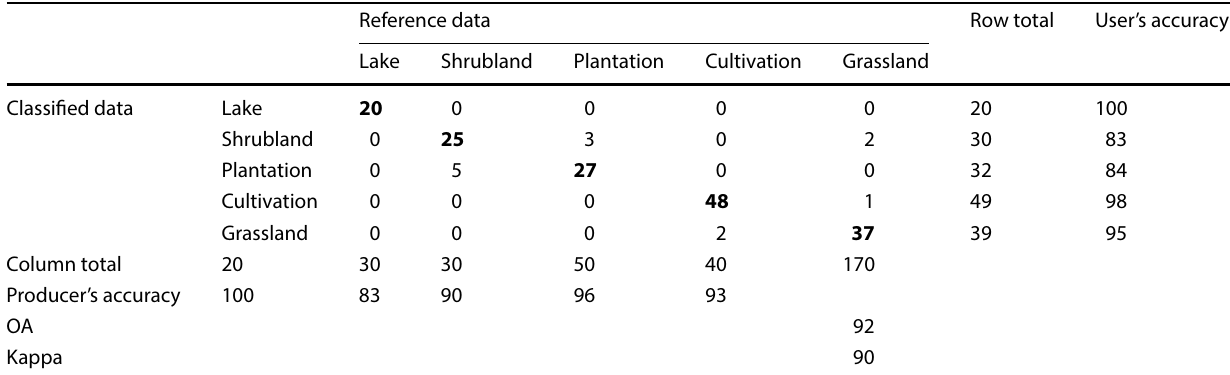
Table 2 Classification accuracy (1989)